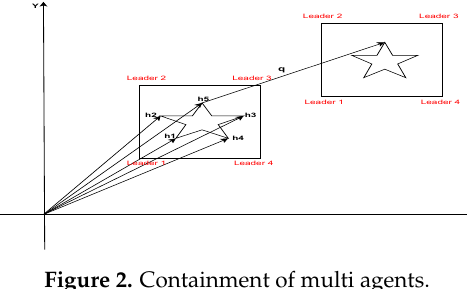
Figure 2. Containment of multi